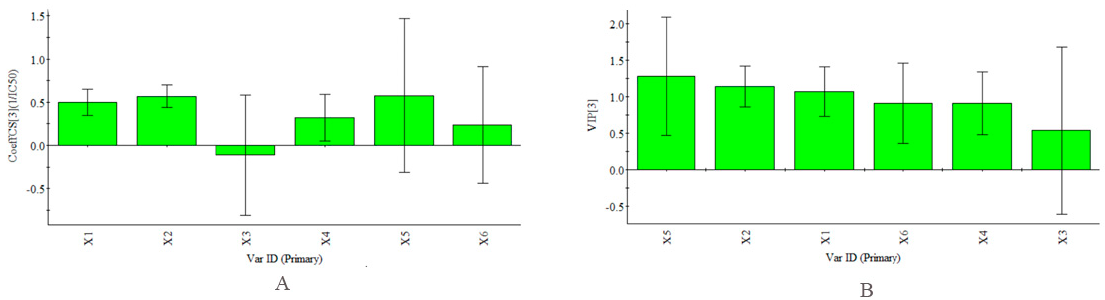
Figure 10. PLS Model (R2X = 0.990, R2Y = 0.998, Q2 = 0.982). ( A ) coefficients plot. The bars indicate 95% confidence intervals based on jackknifing; ( B ) VIP plot. Plots given by the SIMCA-P+ software (Version 13.0).